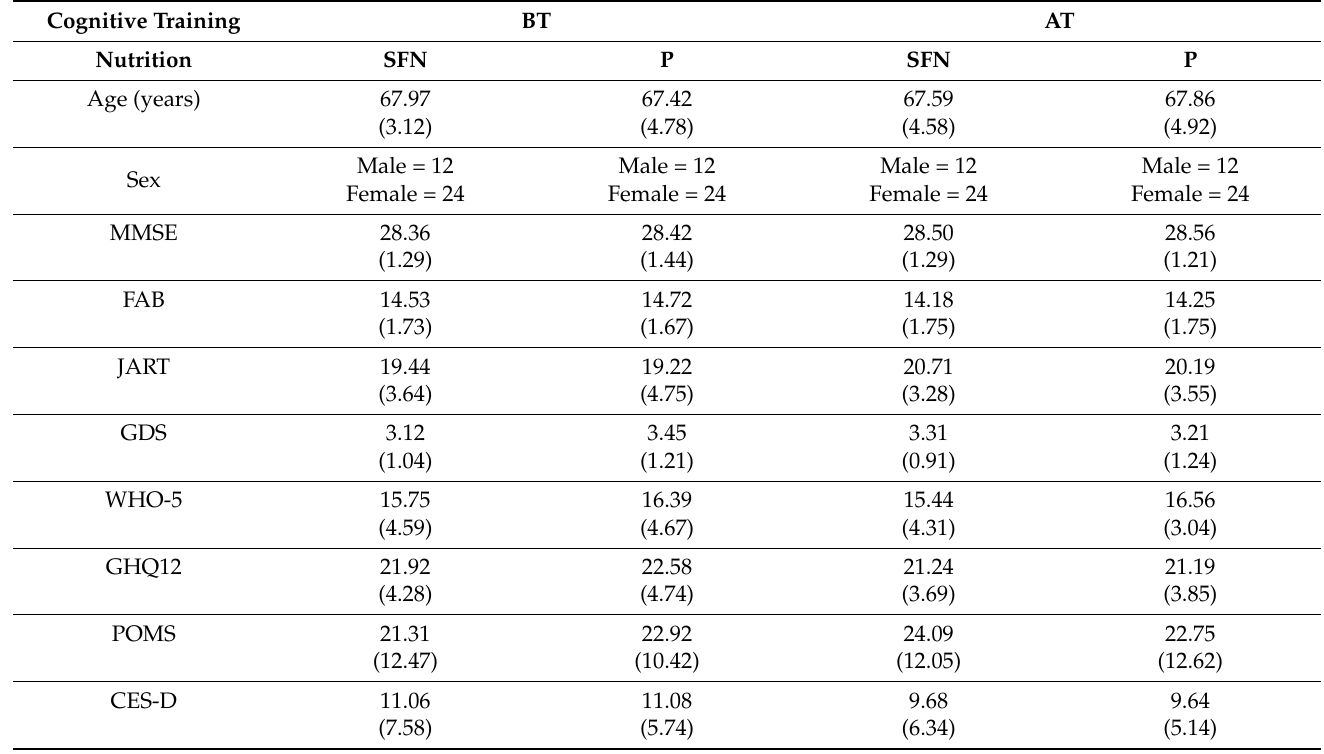
Table 1. Age, depression, and general cognitive function scores of the participant groups at